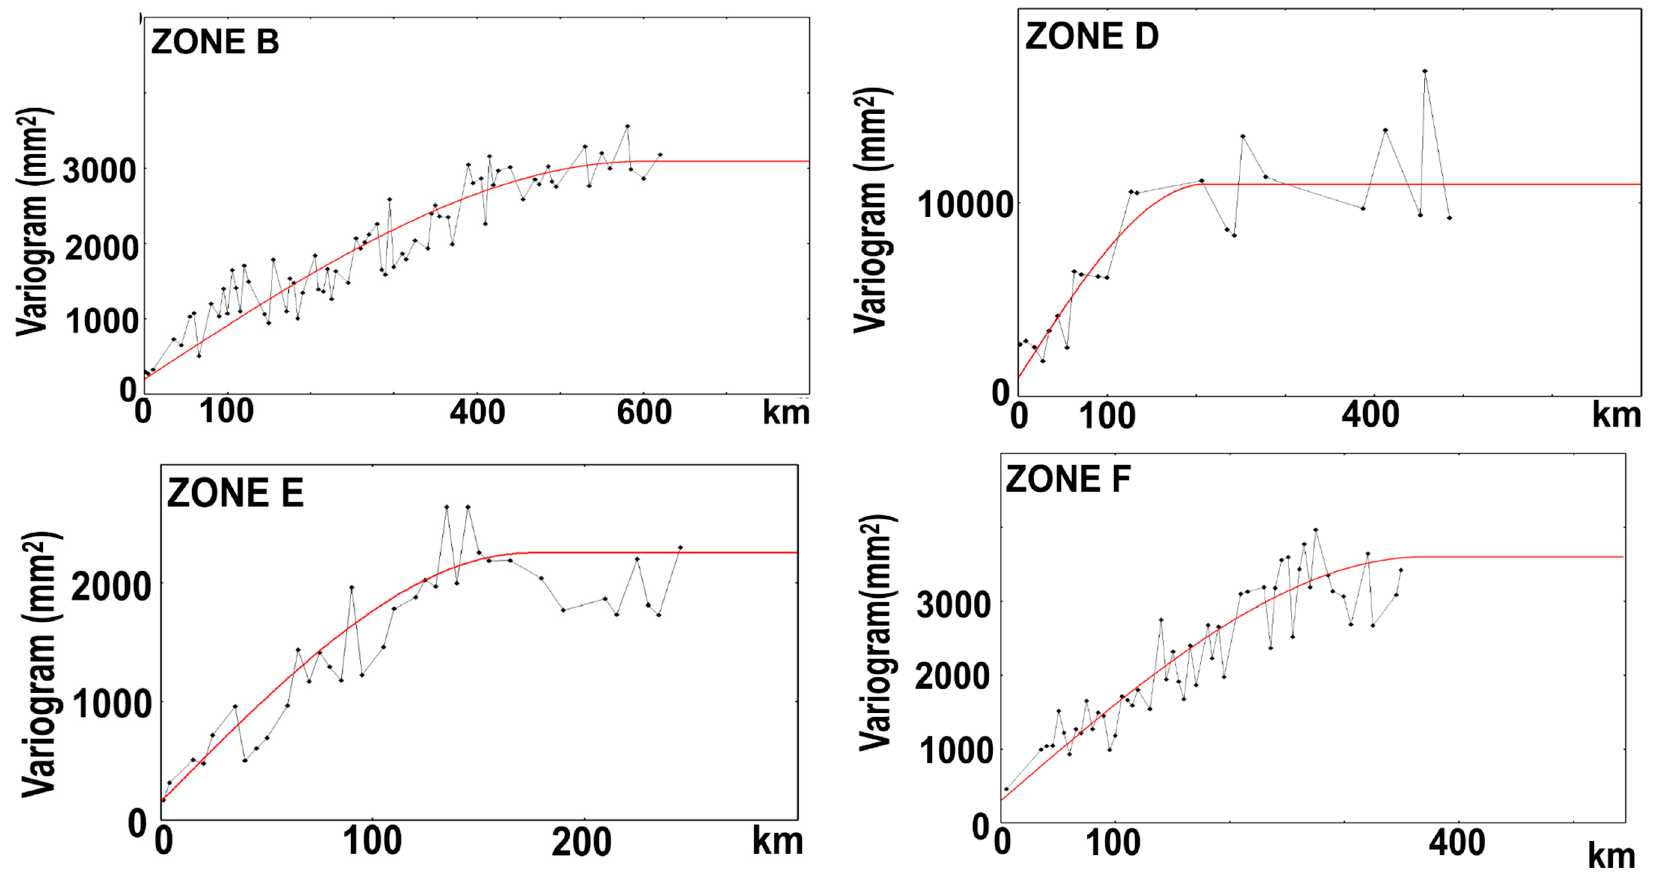
Figure 4. SWE variograms in zones B, D, E, and F. The experimental variograms (black) and the adjustment models (red).